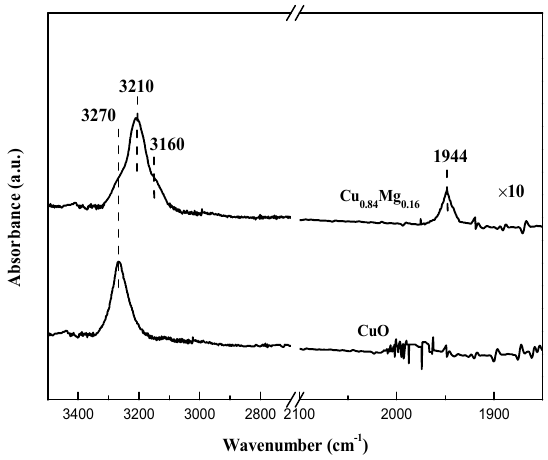
Figure 14. C 2 H 2 -IR spectra of catalysts after reaction.